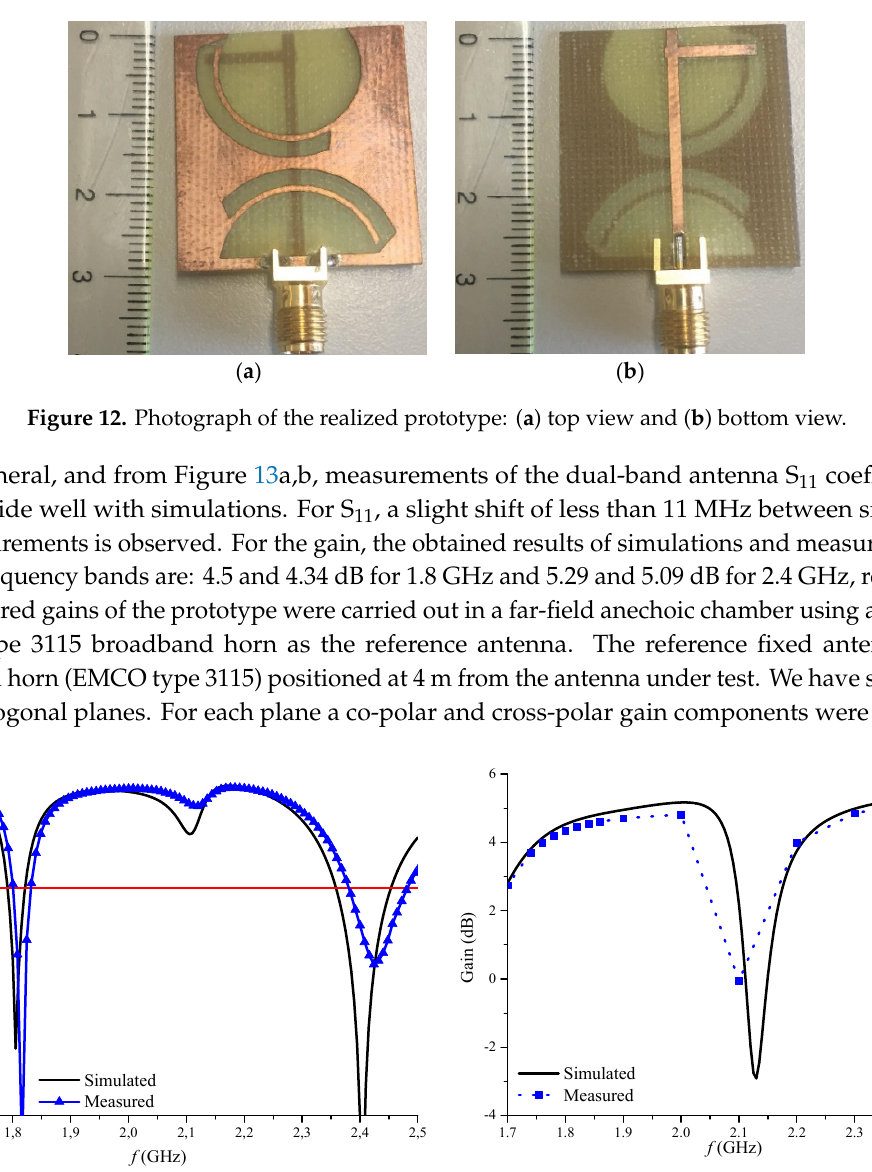
Figure 11. Normalized radiation pattern at: ( a ) 1.8 and ( b ) 2.4 GHz.